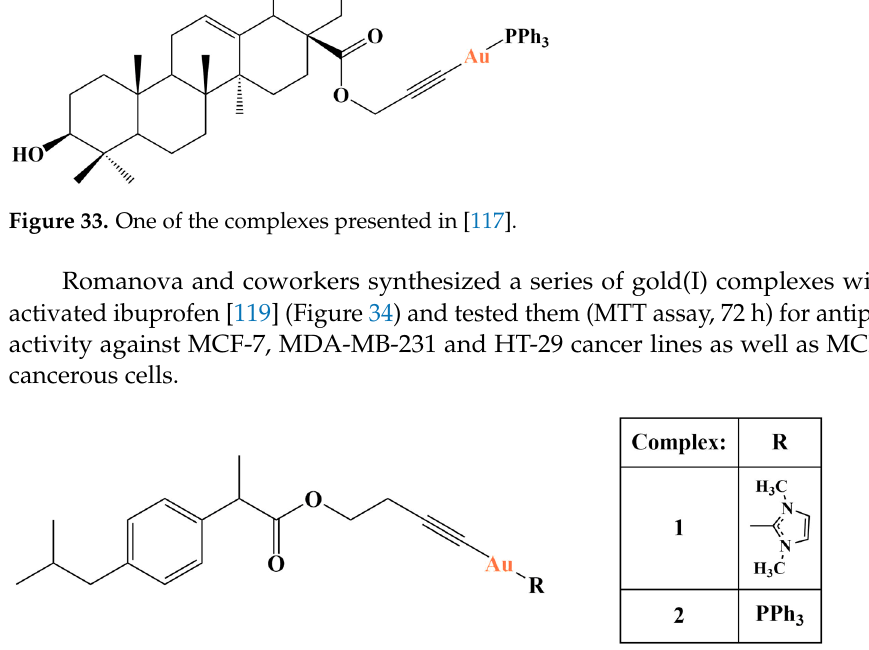
Table 4. Summary of the gold complexes presented.